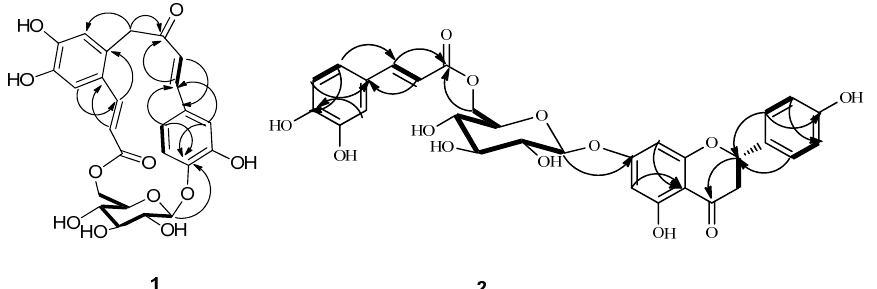
Figure 2. Key 1 H- 1 H COSY (bold lines) and HMBC (H → C) correlations of compounds 1 and 2